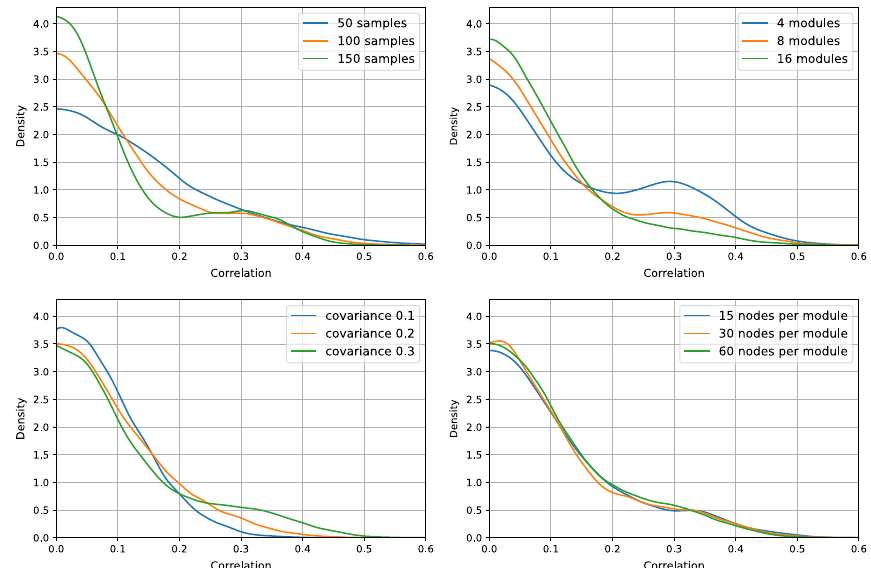
Fig. 2 Synthetic data. The distribution of empirical correlations calculated from the planted partitions varies with the number of samples (upper left), number of modules (upper right) and planted covariance (lower left), but seemingly not with the module size (lower right). More samples, fewer modules and large within-module covariance gives a stronger signal of modular structure in the